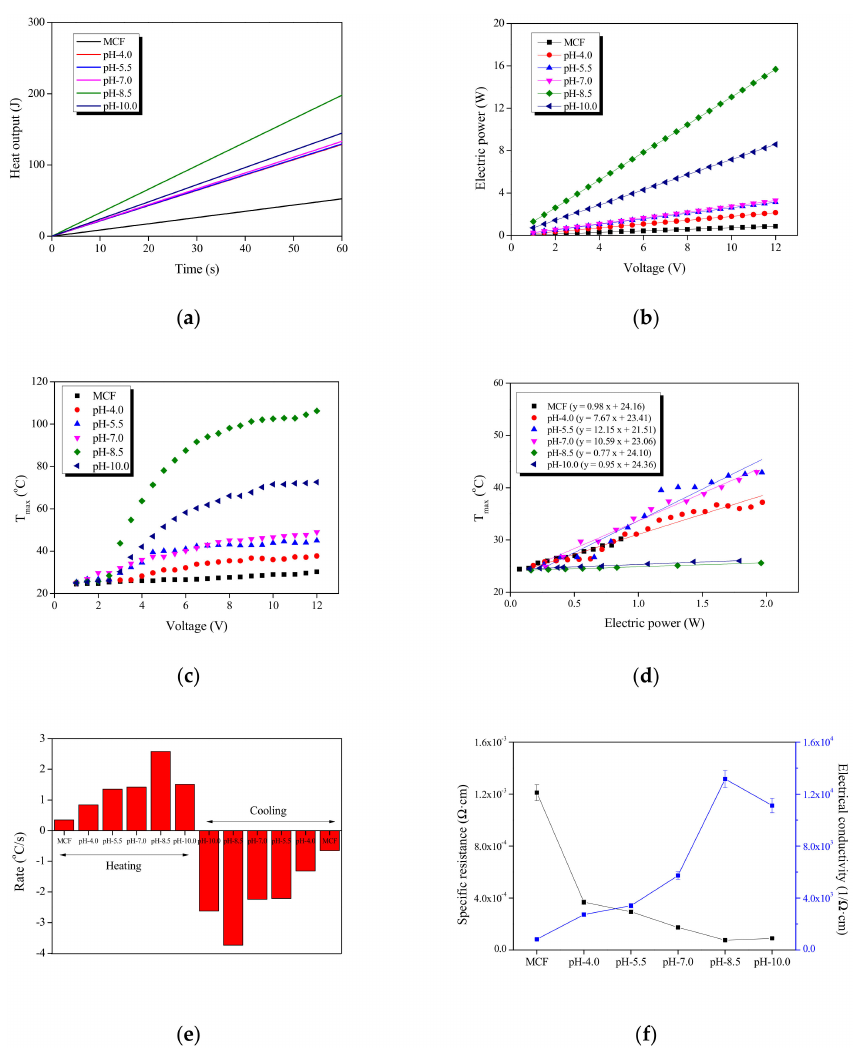
Figure 9. Thermal and electrical properties of MCF as a function of the pH of the plating bath: ( a ) heat output, ( b ) electric power-voltage curves, ( c ) applied voltage changes of T max , ( d ) electric power changes of T max , ( e ) heating / cooling rate, and ( f ) electrical properties.